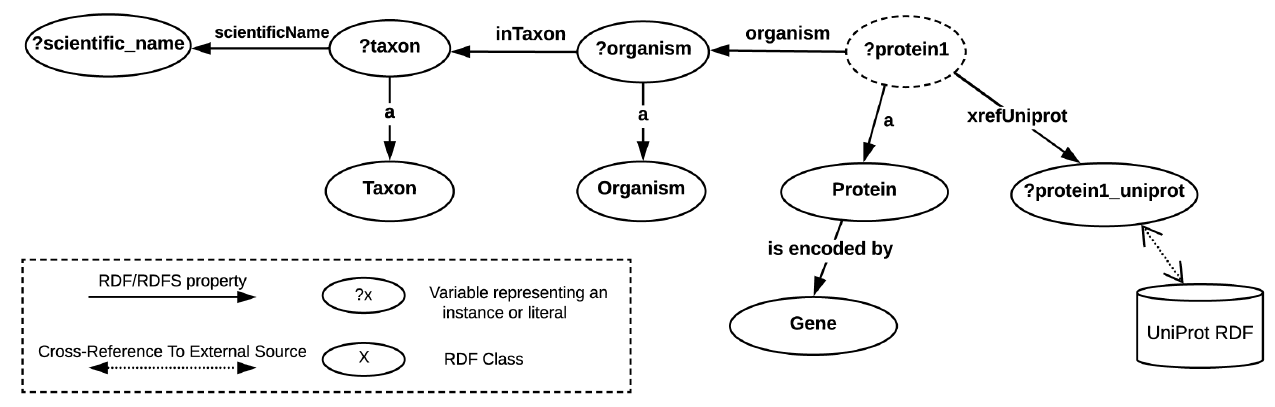
Figure 1. Simplified query graph that can be used as support for writing SPARQL queries to extract relevant information, such as proteins in a particular